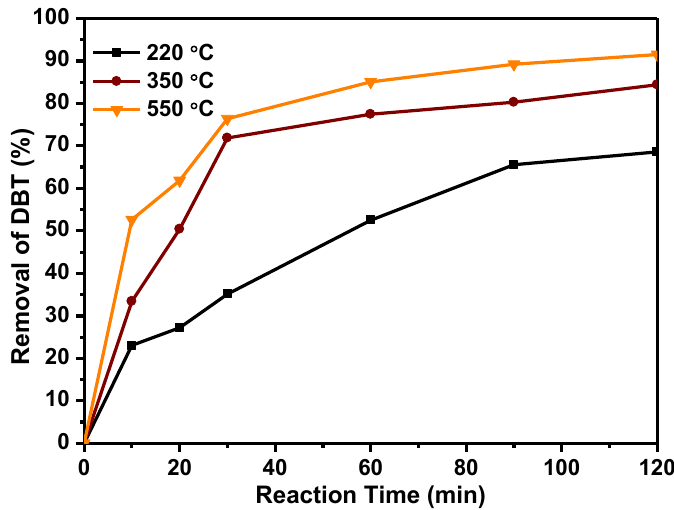
Figure 5. Calcination temperature effect on ODS performance of 30%Ti-MIL-101.